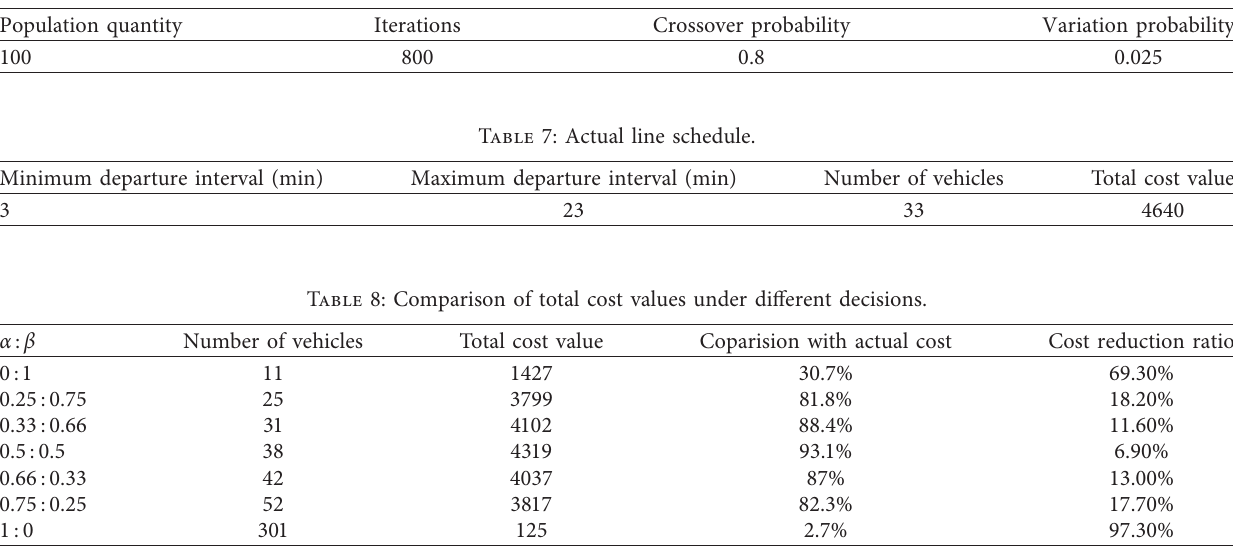
Table 6: Driving time fitting parameters between the stations during the study period.